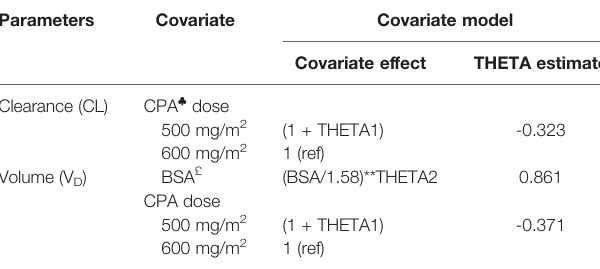
TABLE 4 | Covariate model analysis of cyclophosphamide.